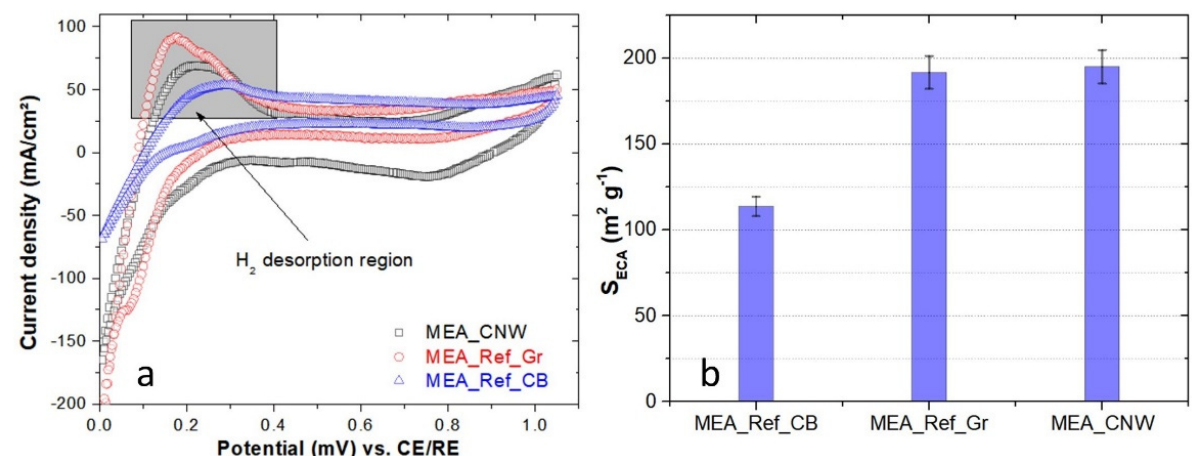
Figure 7. ( a ) CV tests were performed directly on MEAs, at a low scanning rate of 20 mV s − 1 while feeding the anode (reference/auxiliary electrode) with nitrogen and the cathode (working electrode) with air, both at backpressure of 70 kPa, at 80 °C and 80% RH. ( b ) The electrochemically active surface of platinum catalyst in MEA with different MPLs: carbon black, commercial graphene, CNWs.